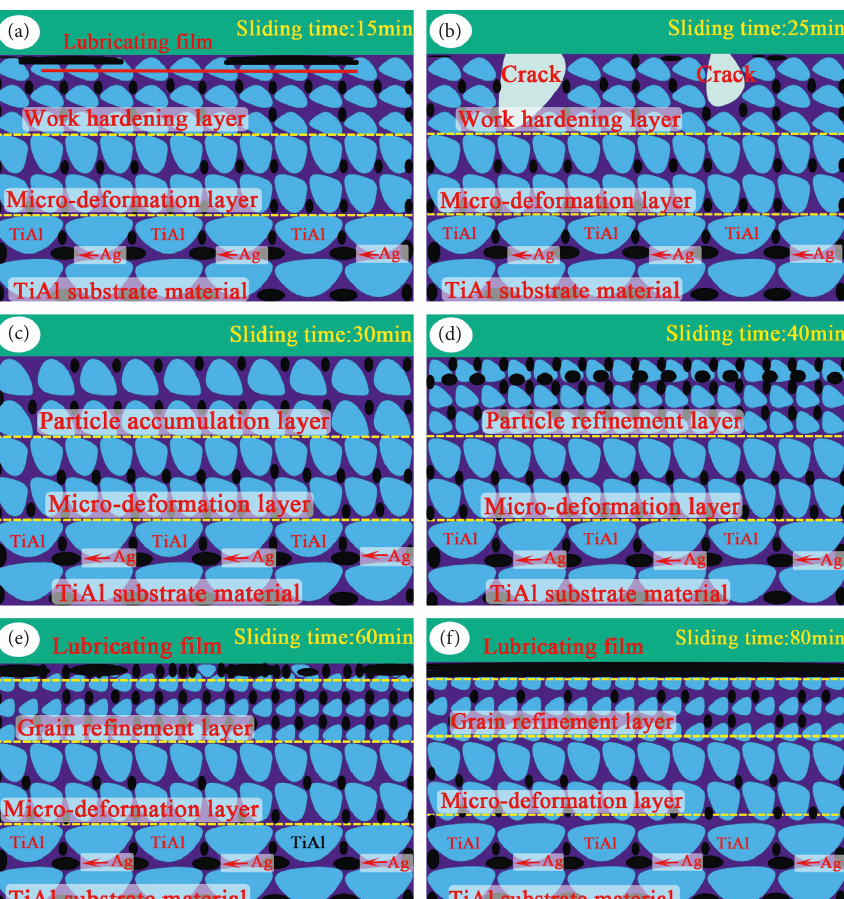
Figure 11: A typical schematic diagram on cross-sectional structure evolution of the wear scars with the increase in sliding